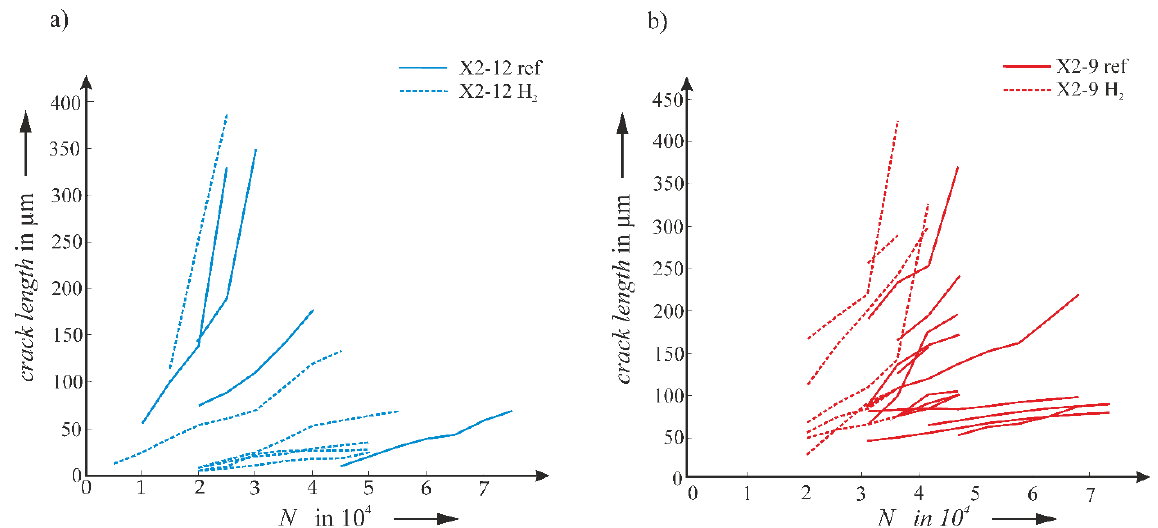
Figure 3. Fatigue crack growth curves of ( a ) X2-12 and ( b ) X2-9 in reference and precharged conditions, tested at a stress ratio of R = − 1, f = 1 Hz, and a stress amplitude of 365 MPa (X2-12), 430 MPa (X2-9 H 2 ), and 460 MPa (X2-9 ref) [4] (reproduced from [4], MDPI, 2018).